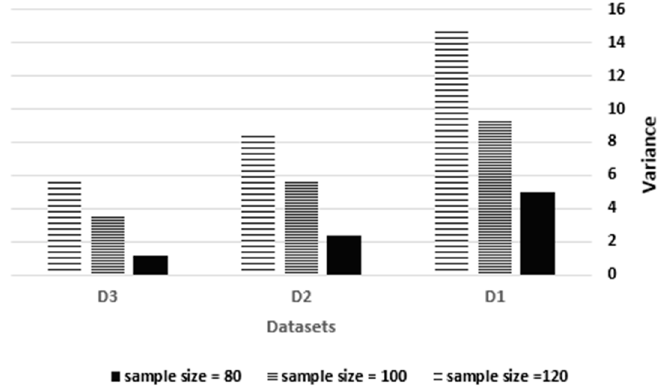
Figure 9. STDF sample variance vs. the sample size.